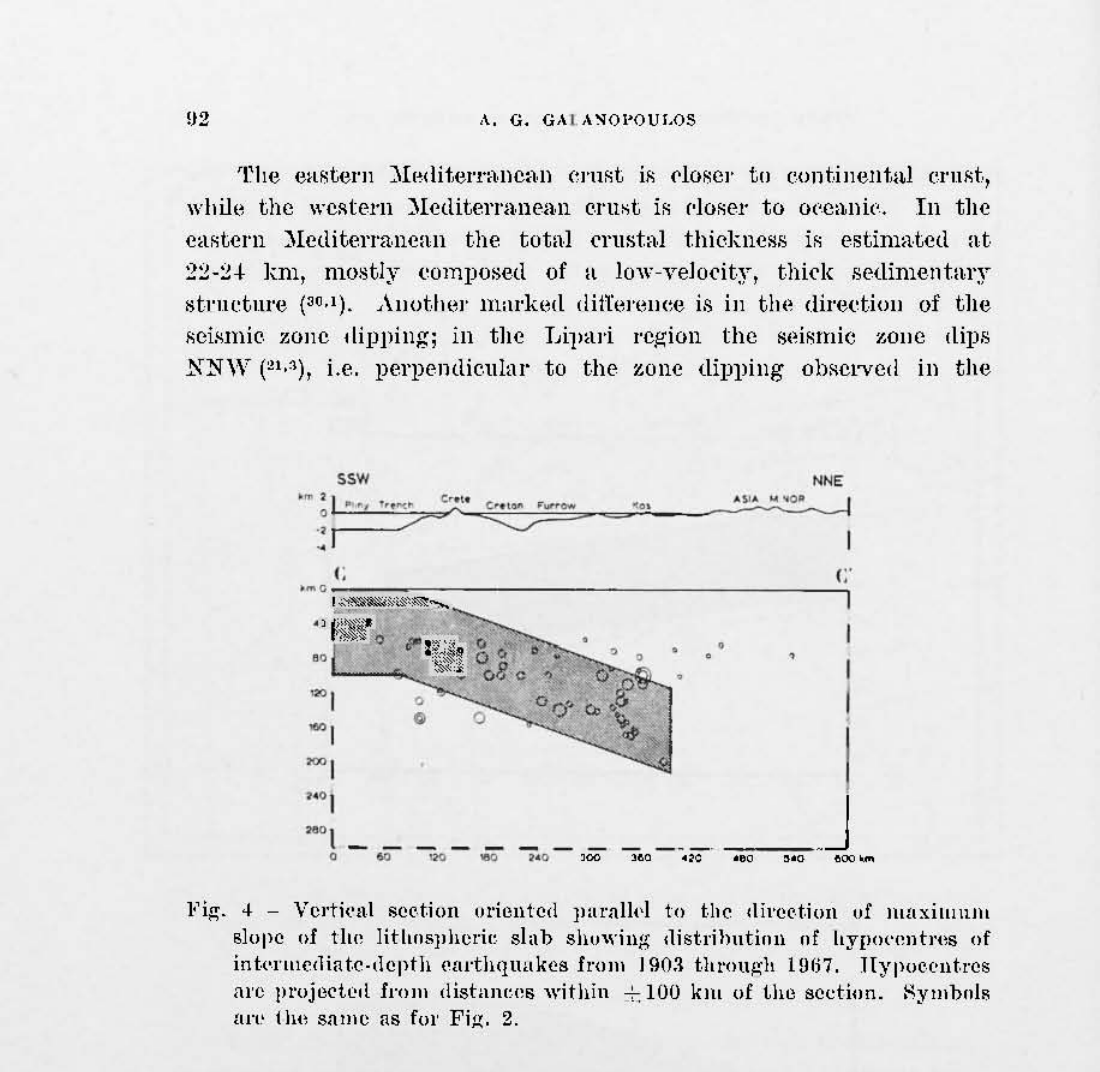
Fig'. 4 - VCl'tknl seet.ion oriented paralll'l to thc 11il'eet.ion of lIWXiUllllll slopc oI tlw lithnsphcrie slab sllOwing 11istrihlltinn nf hypo('pntres of inh'Tlllcl1iat.c'11epth eurthquakcs Irolll J903 throup;h 19(j7, JIypocent.rcs arc projectel1 Irolll distaneps within +: 100 klll of ilie scctiun. HYlllbnls un' tlw salllC as for Fig,